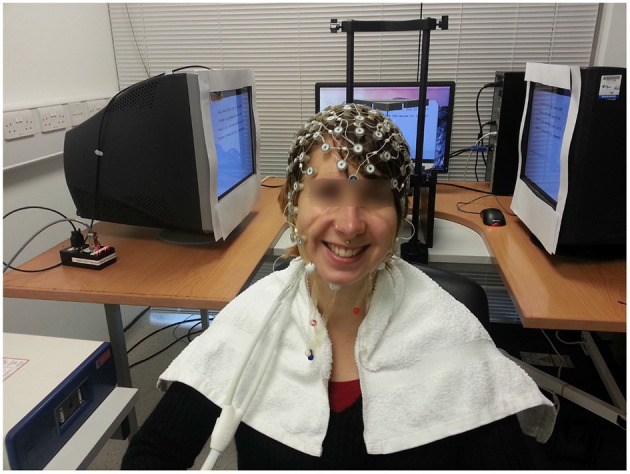
One cheerful participant wearing our 128-channel EGI electrode cap, sitting in front of the 3D display. The mirror assembly of the Wheatstone stereoscope is just behind her head.